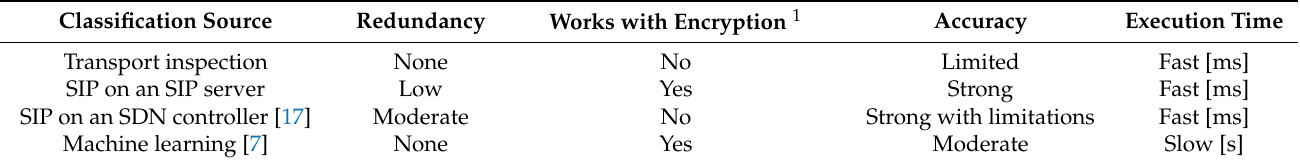
Table 1. Comparison of classification